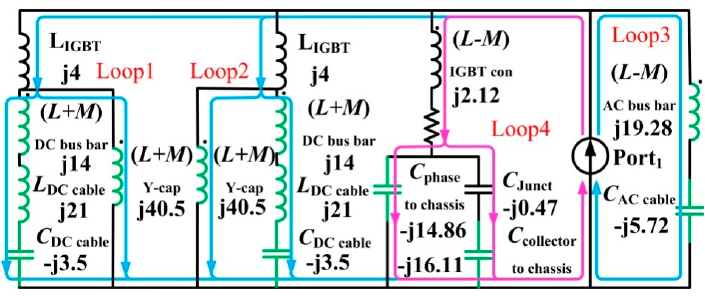
Figure 10. Equivalent circuit at 26 MHz. Table 2. Elements responsible for resonances.